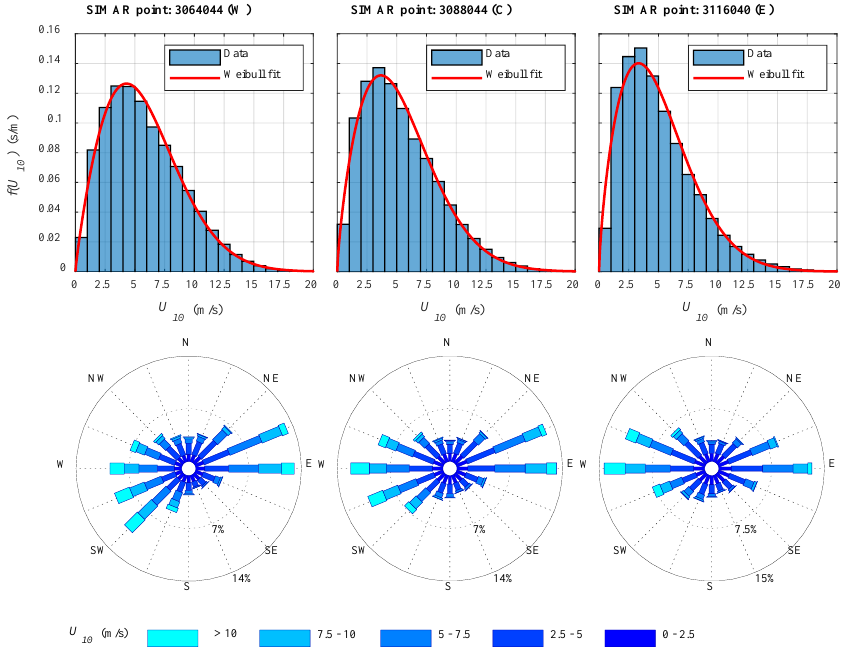
Figure 6. Probability Density Functions and wind roses at three study sites in the West, Centre, and East sections of the study area.